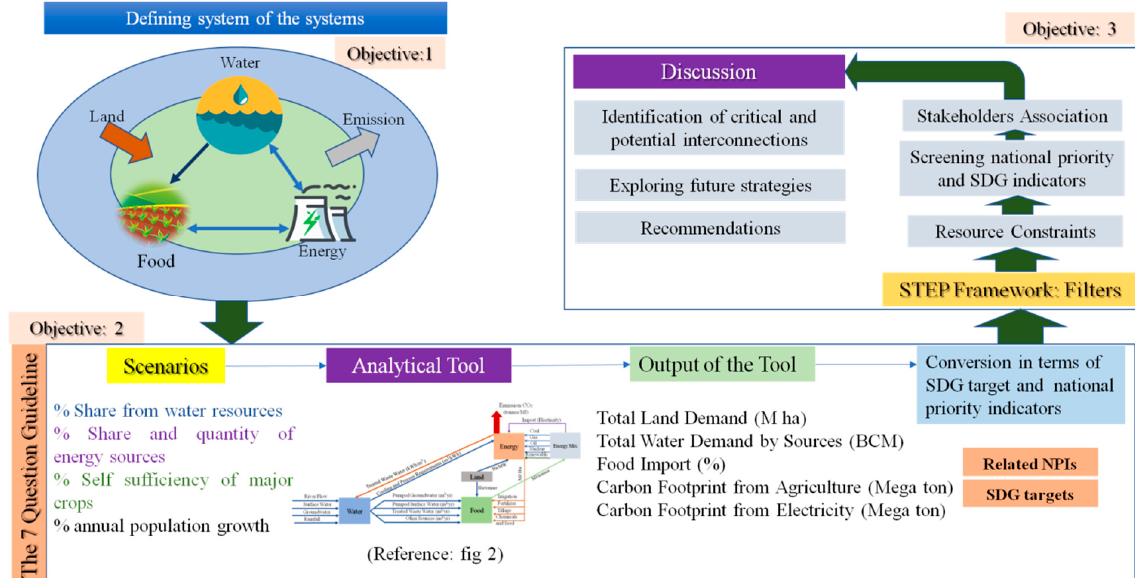
Figure 3. Conceptual framework for water, energy, and food assessment.